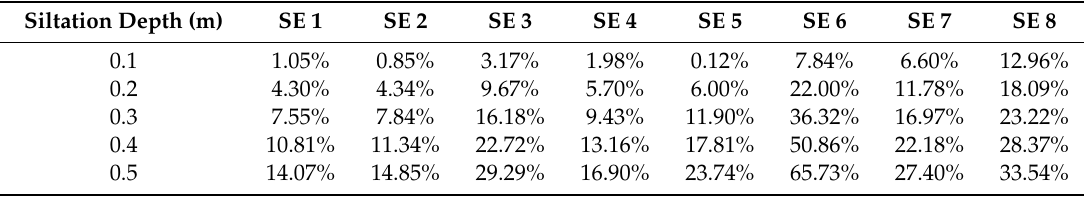
Table 4. Reduction ratio of e-flow requirement for di ff erent river segments (SE) under the